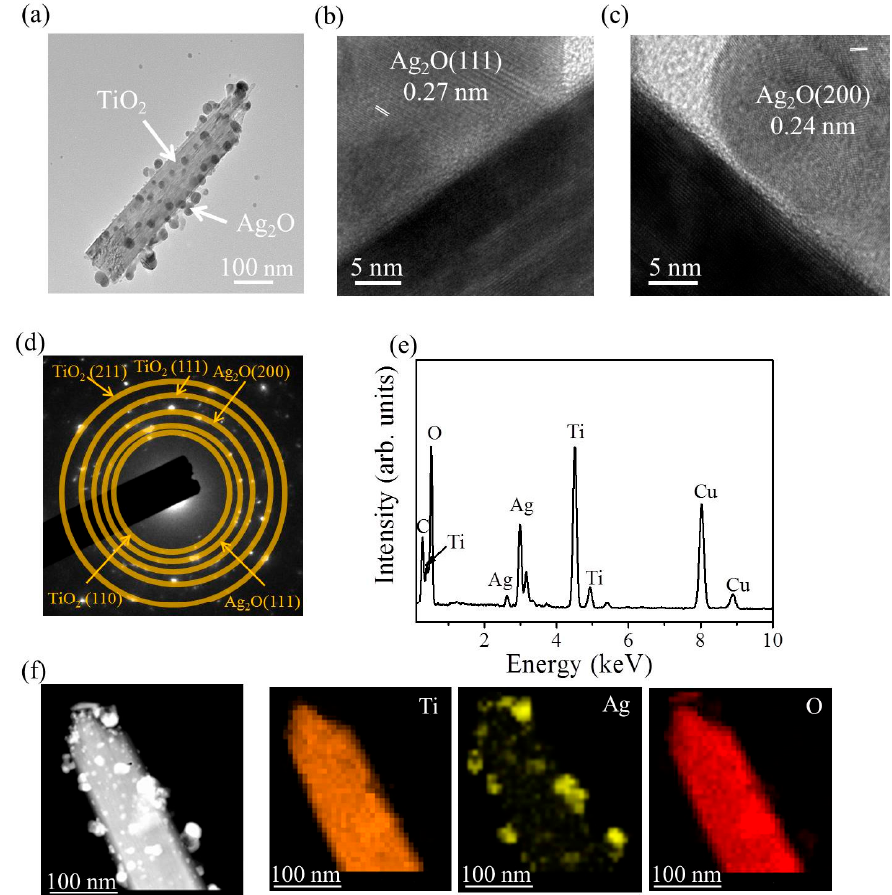
Figure 4. TEM analysis of the TiO 2 –Ag 2 O-1 composite nanorods: ( a ) Low-magnification TEM image of the TiO 2 –Ag 2 O-1 composite nanorod. ( b , c ) High-resolution TEM images taken from various regions of the composite nanorod. ( d ) Selected area electron di ff raction (SAED) pattern of several TiO 2 –Ag 2 O-1 composite nanorods. ( e ) Energy dispersive X-ray spectroscopy (EDS) spectrum of the composite nanorod. ( f ) Ti, Ag, and O elemental mapping images taken from the selected composite nanorod.